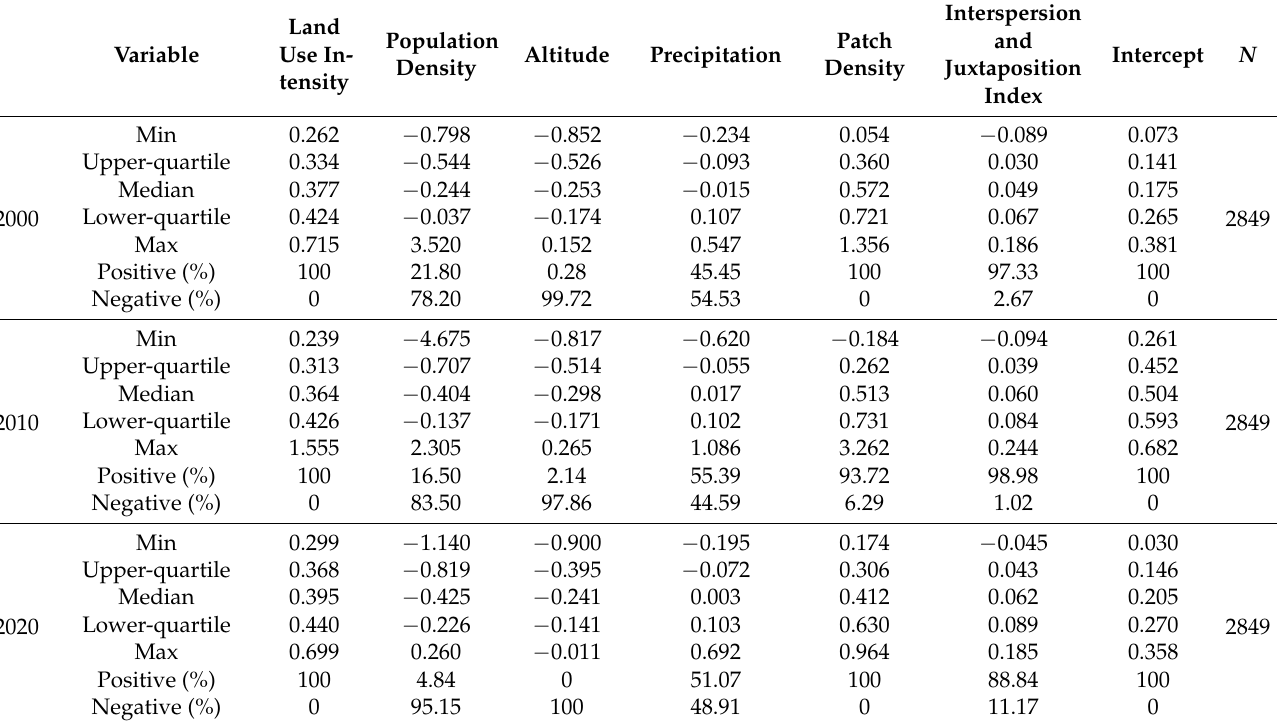
Table 6. Statistical results of the GWR model regression coefficient during